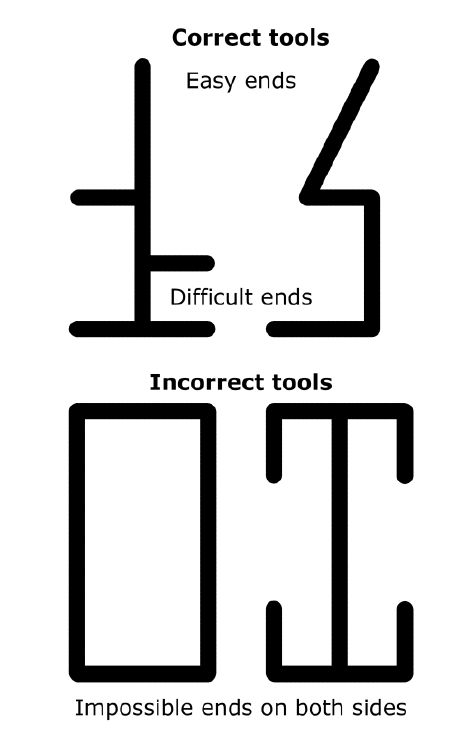
Sticks that Povinelli (2000, Experiment 11) Presented to Chimpanzees to Insert Through a Circular Aperture to Push a Piece of Food within their